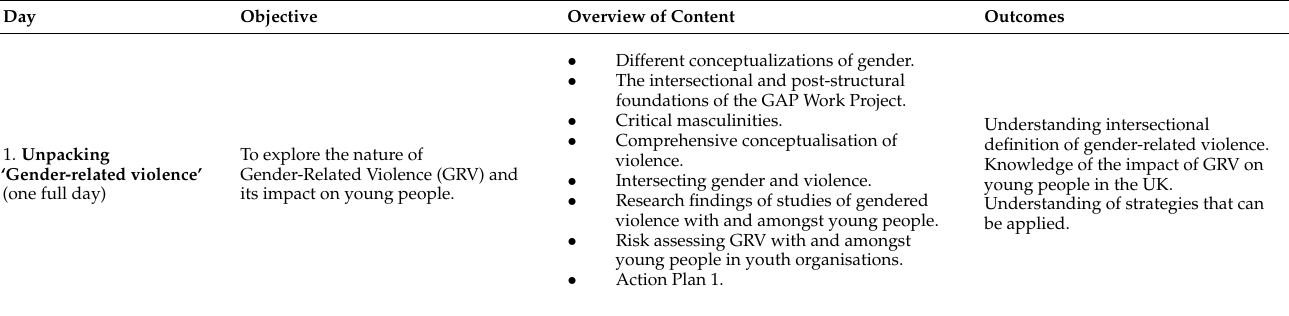
Table A1. An Overview of the UK GAP Work Project Training